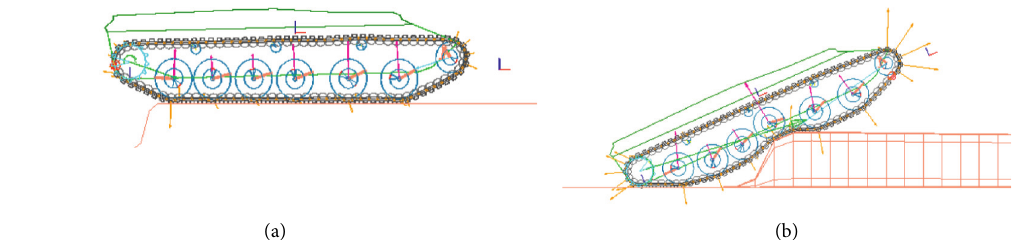
Figure 14: Simulation process of a vehicle crossing a vertical wall. (a) 0.9 m vertical wall. (b) 1.0m vertical wall.